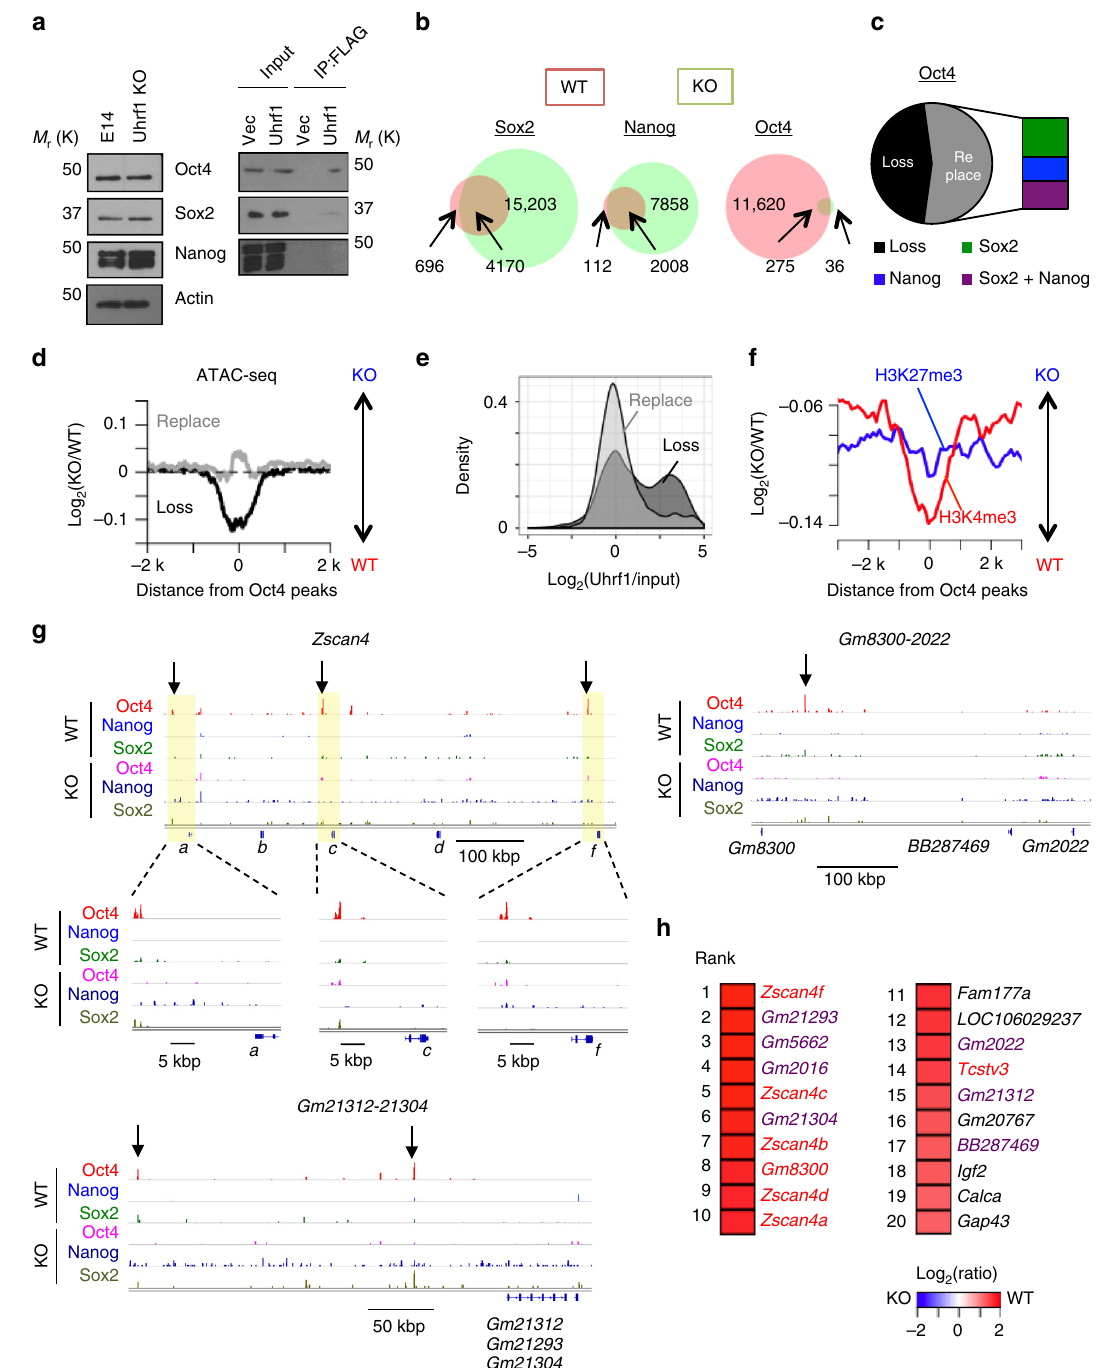
Fig. 5 Uhrf1 modulates core pluripotent factor binding. a Co-IP experiment of Uhrf1 with core pluripotent factors. b Venn diagrams showing differential binding of core pluripotent factors between WT and Uhrf1 KO ESCs. c Ratio of loss and replacement of Oct4 binding. d ATAC-seq read distribution around Oct4-binding sites. Log 2 (KO/WT) of normalized ATAC-seq read count was drawn in the location of loss (black) and replacement (gray) of Oct4 binding, separately. e Enrichment of Uhrf1 binding on Oct4-binding sites. f ChIP-seq read distribution for H3K4me3 and H3K27me3 around the location of the loss of Oct4 binding. Log 2 (KO/WT) was drawn. g Binding landscape of core pluripotent factors in 2C-speci fi c gene clusters. h Top 20 down-regulated genes in Uhrf1KO ESCs. Known and previously uncharacterized 2C genes were shown by red and purple colors